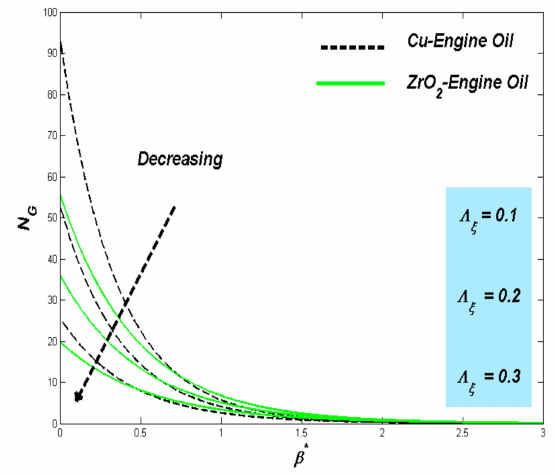
Figure 13. Entropy profile change with Λ ξ